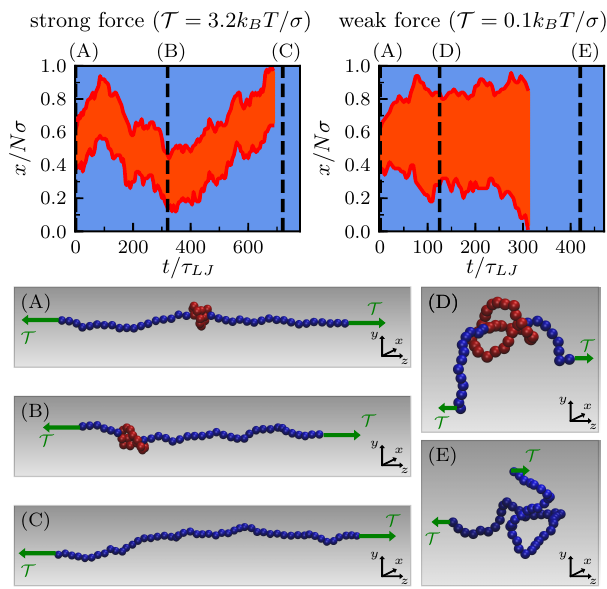
Figure 1. Kymographs of the unknotting dynamics of a trefoil knot tied in a linear polymer of N = 50 beads under strong ( left ) and weak ( right ) external pulling. Red highlights the knotted portion, blue indicates dangling ends; x is the chemical coordinate along the backbone. Panels ( A – E ) display different snapshots at increasing